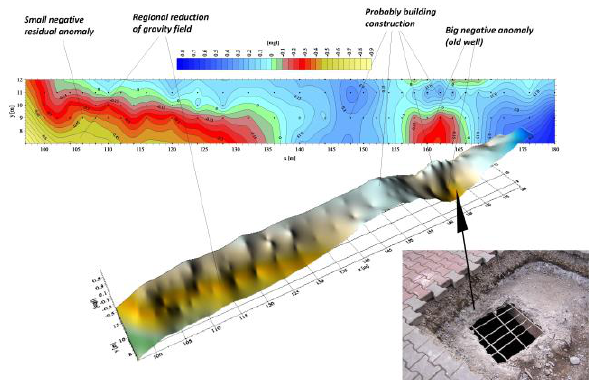
Figure 2. The 2D and 3D image of the gravity field with the finding a covered old dry well.